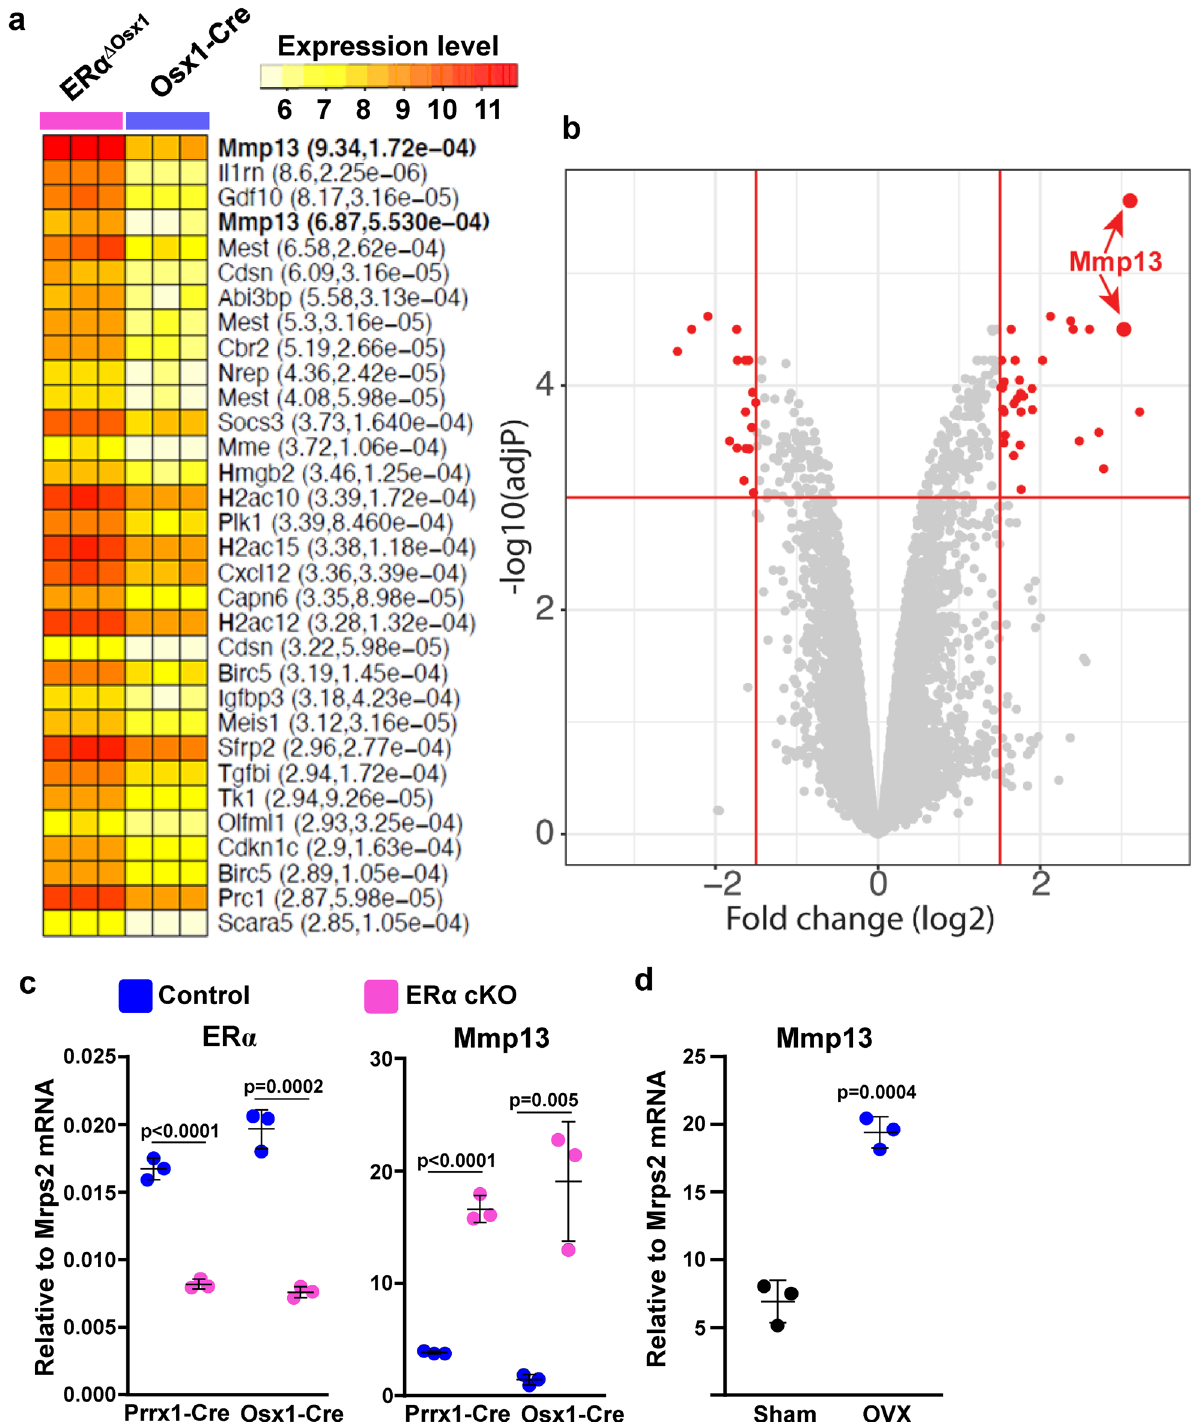
Figure 1. Mmp13 is downregulated by estrogens. ( a ) Microarray analysis of GFP-sorted Osx1 + cells without or with ERα, derived from calvaria cells of ERα ΔOsx1 mice or Osx1-Cre controls. Heat map shows the normalized expression values of the top highly up-regulated genes (log2 fold change > 1.5 and adjust P values < 0.001) of individual sample. Gene names are shown on the right-side of the heatmap with fold change and adjusted p values. Mmp13 gene, which has 2 probe sets, is in bold letters. ( b ) Volcano plots showing the profiles of differential gene expression. The gene that passed the cutoff of log2 fold change > 1.5 and adjusted P values < 0.001 are represented by red color dots. Mmp13 gene, which has 2 probe sets is pointed to by the red arrows. ( c ) Relative mRNA levels of ERα and Mmp13 in bone marrow stromal cell cultures derived from littermate control (ERα floxed) or ERα conditional KO mice (cKO) using Prrx1-Cre; or in calvaria cells from Osx1-Cre or ERα cKO using Osx1-Cre . ( d ) mRNA levels of Mmp13 in bone marrow stromal cell cultures from ovariectomized and sham operated wild type mice (each sample is a pool of 3–4 animals from either group). Data represent mean ± S.D.; p values by Mann–Whitney U